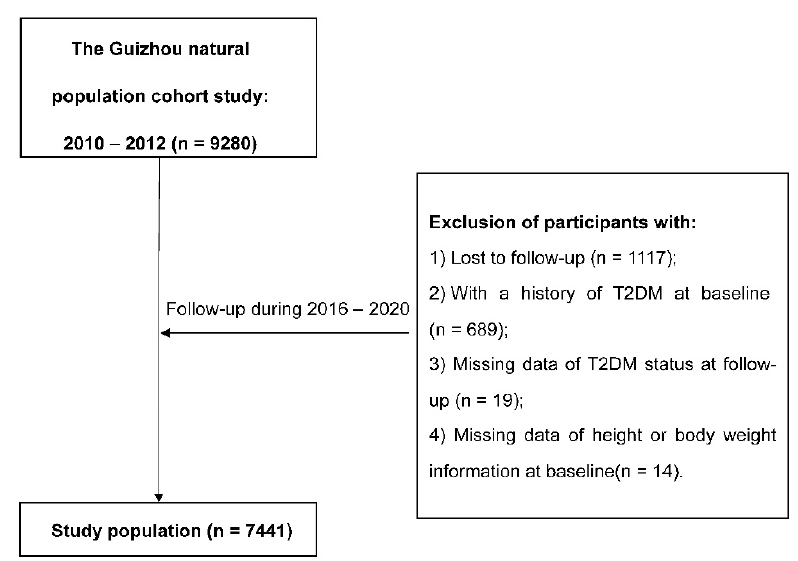
Figure 1. The flowchart. Figure 1. The Table 1. General characteristics of the study population at baseline in Southwest China.